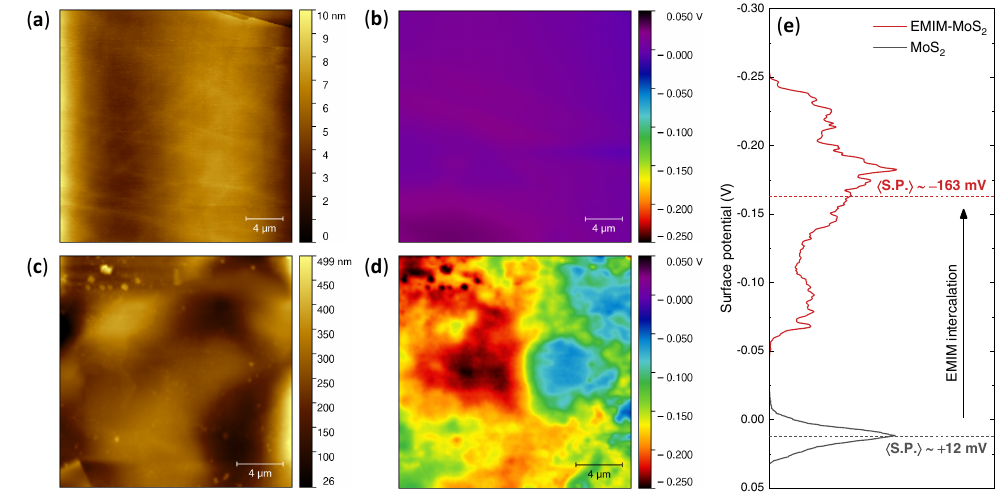
Figure 4. Kelvin-probe force microscopy of pristine and intercalated MoS 2 . ( a ) AFM topography map of pristine MoS 2 . ( b ) Surface potential map of pristine MoS 2 . ( c ) AFM topography map of intercalated MoS 2 . ( d ) Surface potential map of intercalated MoS 2 . ( e ) Surface potential histograms highlighting the shift in the Fermi energy induced by the intercalation of EMIM